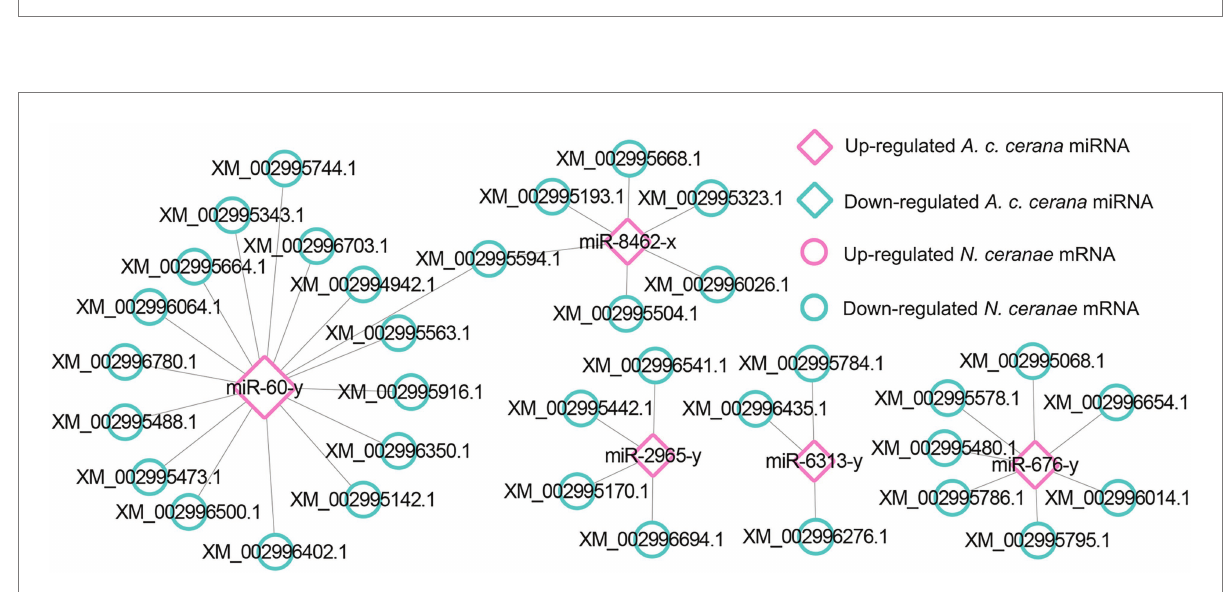
FIGURE 3 Regulatory network between up-regulated miRNAs shared by AcCKmi7 vs. AcTmi7 and AcCKmi10 vs. AcTmi10 and down-regulated mRNAs shared by NcCKm vs. NcTm7 and NcCKm vs.